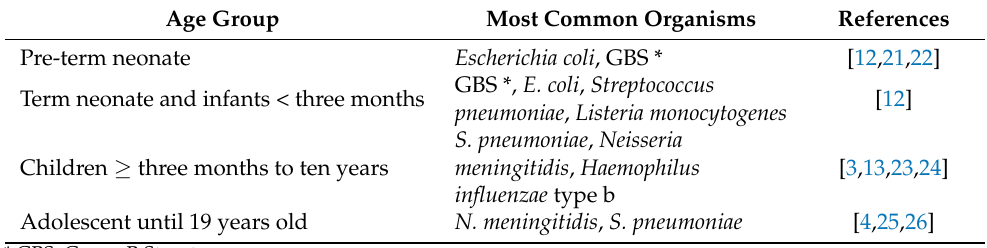
Table 1. Most common organism for different Age